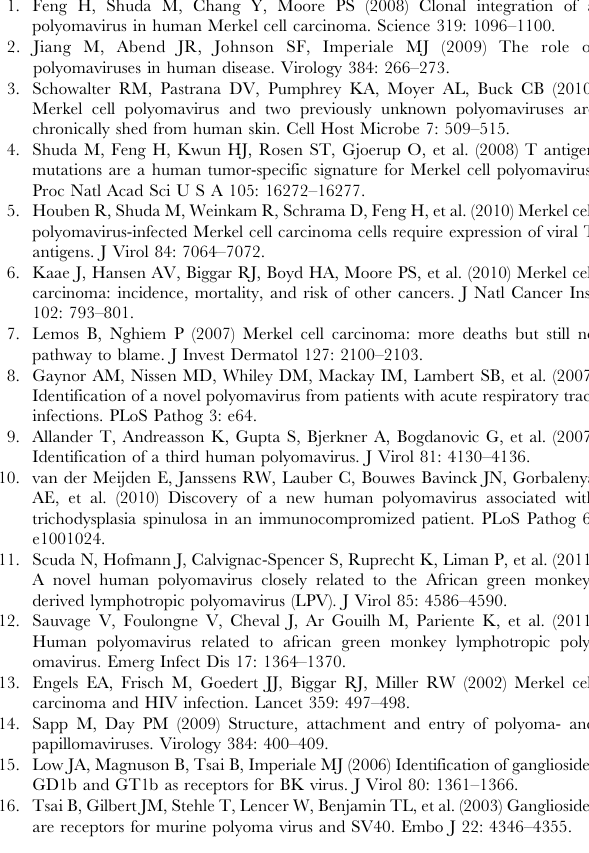
Figure S4 Saturation transfer NMR spectra of MCPyV VP1 and GT1b. (A) GT1b reference. (B) GT1b STD spectrum with MCPyV VP1. Asterisks denote impurities in both